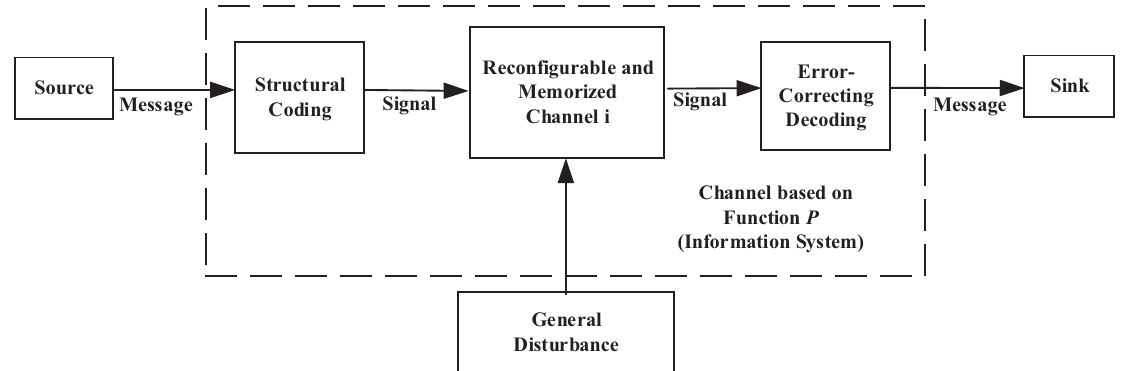
Figure 4. Workflow of a reconfigurable memorized channel to counteract generalized disturbances